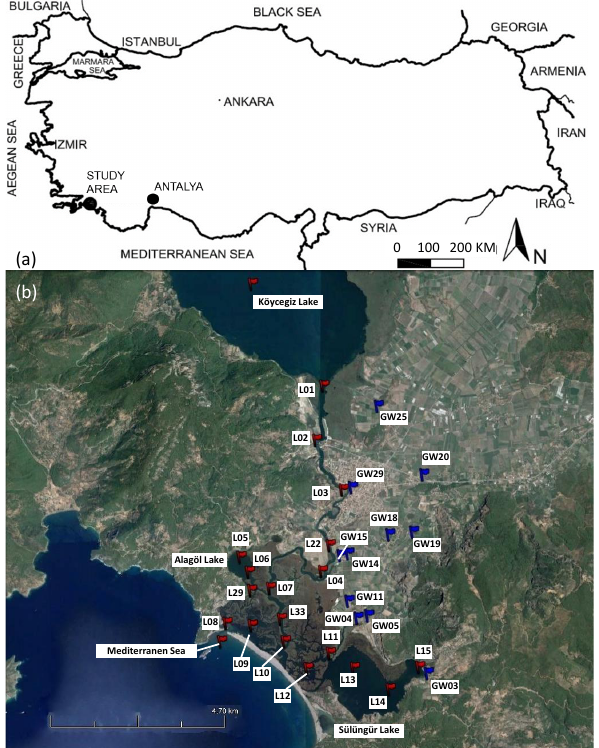
Figure 1. Geographic location of the Köycegiz–Dalyan coastal la- goon (a) and sampling locations (b) ; source of modified satellite picture was Google Earth